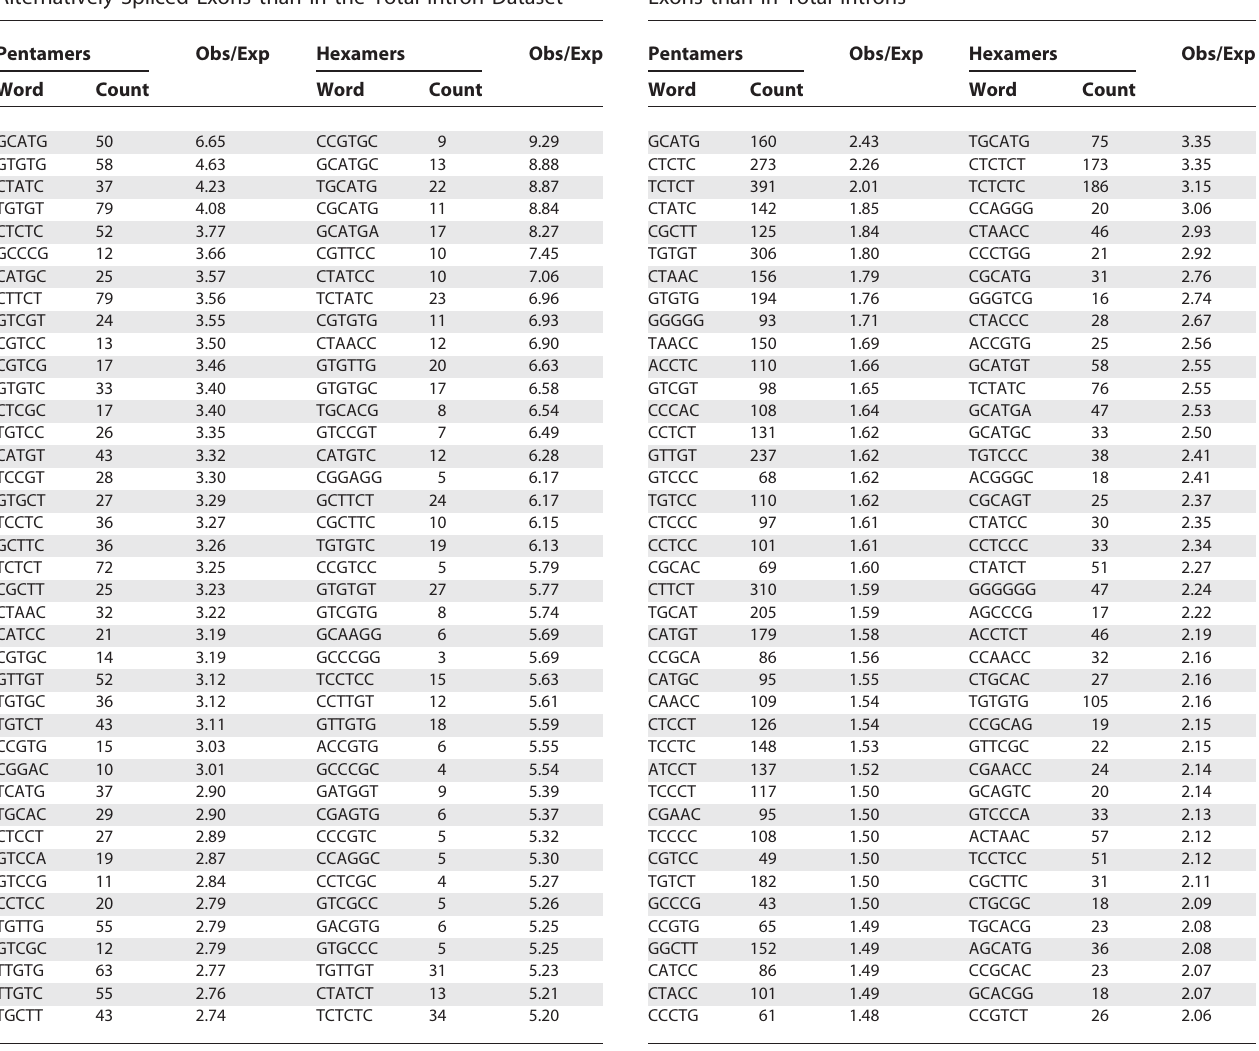
Table 2. Pentamer and Hexamer Sequence Motifs That Occur More Frequently in the Introns Flanking Alternatively